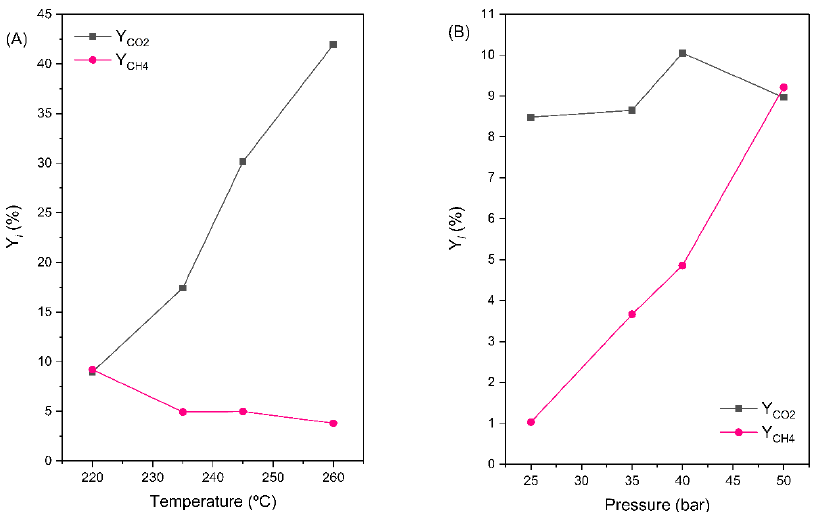
Figure 10. Conversion of CO in the presence of hydrogen over 0.3Pt/CoAl catalyst at 220 °C. Reaction